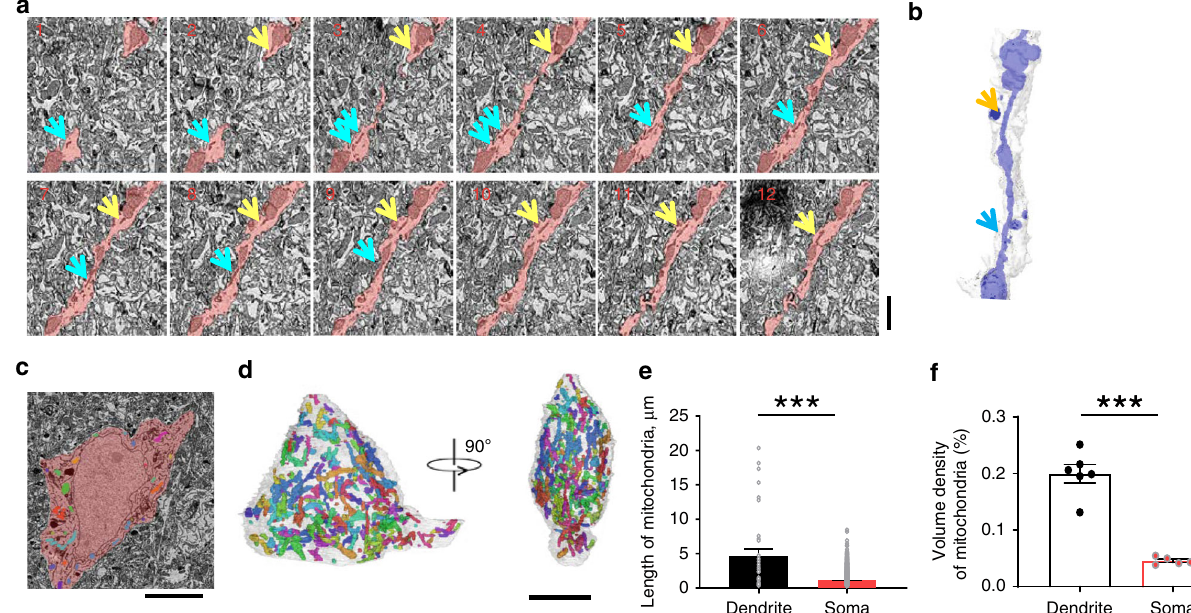
Fig. 1 Mitochondrial morphology in the mouse M1 pyramidal neurons. Data were obtained with automated tape-collecting ultramicrotome scanning electron microscopy (ATUM-SEM). a Gallery view of SEM slices of the dendritic mitochondria. Yellow and green arrows indicate the mitochondria nanotunneling in the dendrite highlighted in pink. Scale bar: 1 μ m. b Volume reconstruction of mitochondria (blue) in the dendrite (semi-transparent white) as shown by the pink area in ( a ). Yellow and green arrows indicate the mitochondria nanotunneling. c Image of a cell body of pyramidal neuron in M1. Scale bar: 5 μ m. d 3D volume reconstruction of mitochondria in the mouse M1 neuron soma (semi-transparent white). n = 291 mitochondria identi fi ed are shown in different colors. Scale bar: 5 μ m. e Statistics of mitochondrial length in dendrites and somas. n = 35 dendritic and 2465 somatic mitochondria. f Volume densities of mitochondria in dendrites and somas. n = 6 dendrites and 5 somas. Data are presented as mean ± SEM. *P < 0.05. **P < 0.01. ***P < 0.0001, unpaired T -test. Source data are provided as a Source Data fi